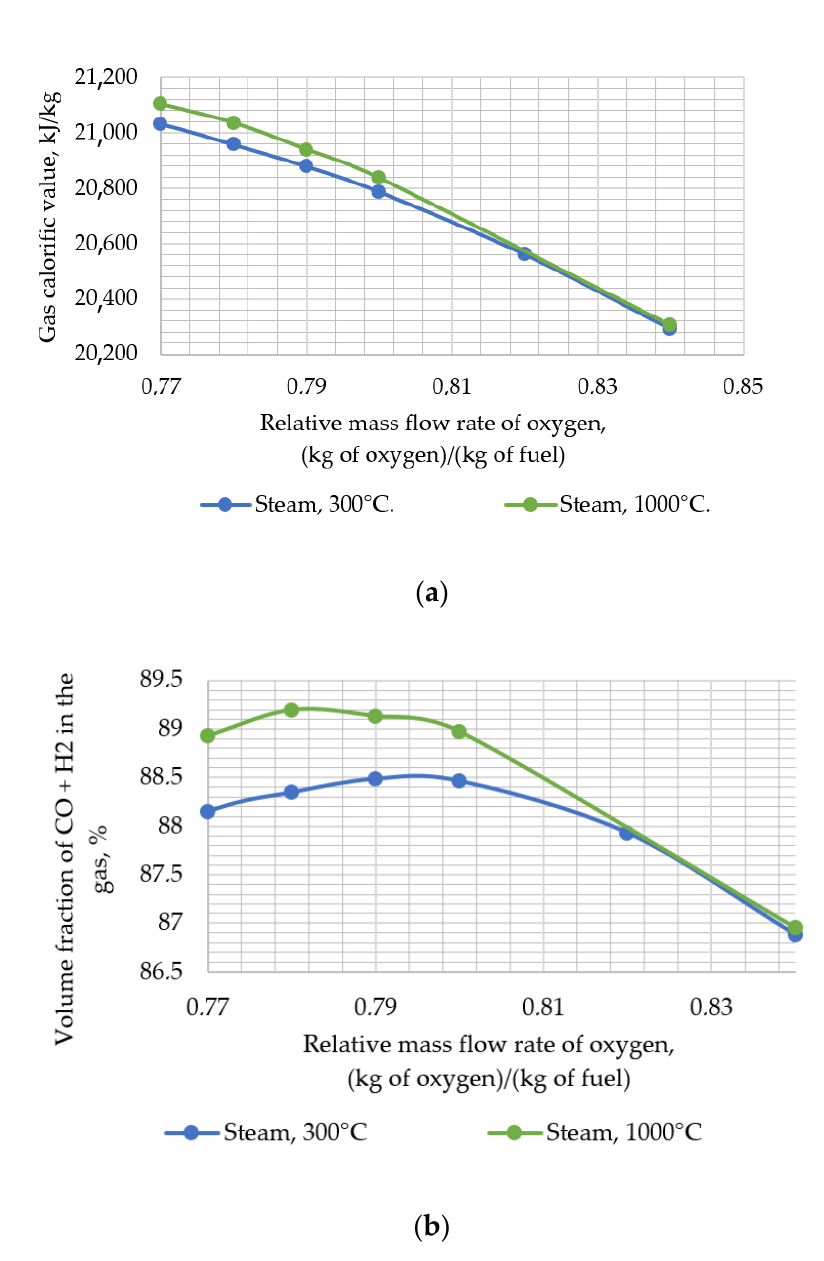
Figure 4. Dependence of syngas output parameters from the relative mass flow rate of oxygen: ( a ) dependence of output parameters from the relative mass flow rate of oxygen; ( b ) dependence of volume fraction of CO + H 2 from the relative mass flow rate of oxygen.